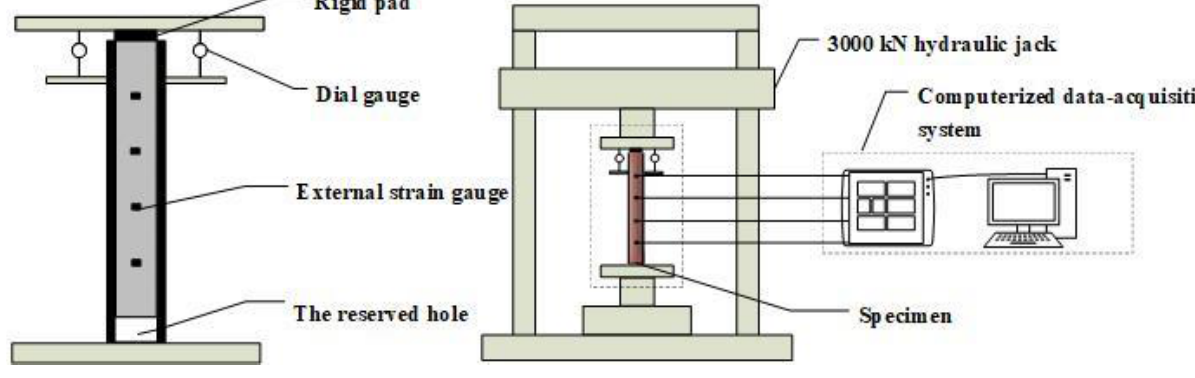
Figure 2. Test device model of CFST.